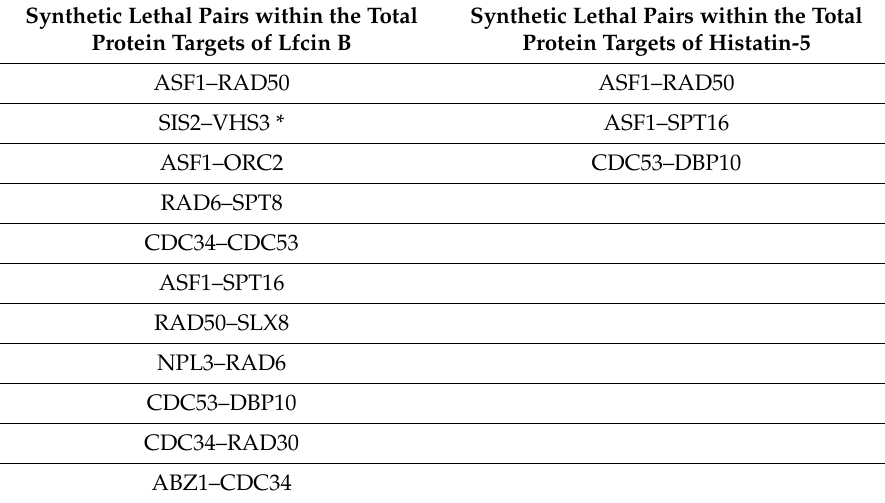
Table 1. Synthetic lethal pairs within the total protein targets of Lfcin B and Histatin-5. * denotes paralog pairs among the identified synthetic lethal